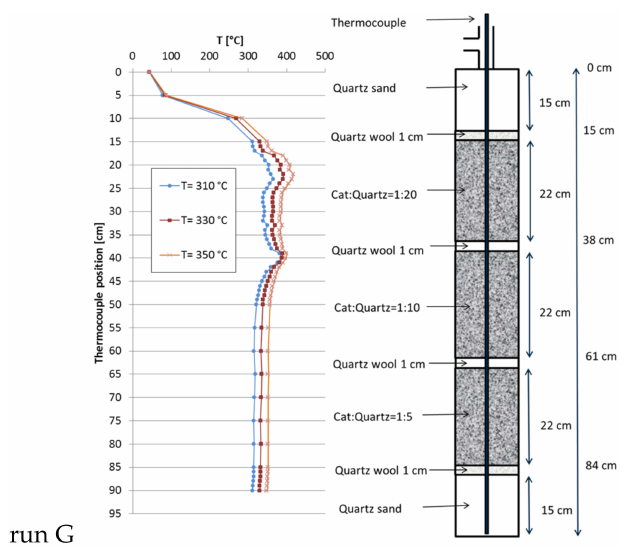
Figure 7. Recorded temperature profiles for methanation on 18Ni/Al 2 O 3 in a triple fixed-bed (30 mL of catalyst; catalyst:quartz = 1:20, 1:10, 1:5; 301 mL total; GHSV = 10,000 h − 1 ; CO 2 :H 2 :N 2 = 1.8:7.2:1; 10 bar).